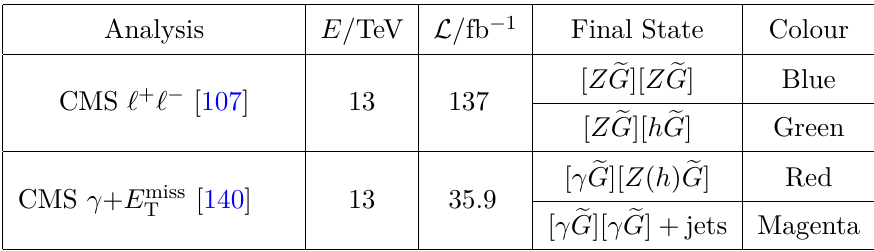
Table 10 . Analyses in CheckMATE which are relevant for GMSB scenario with neutralino